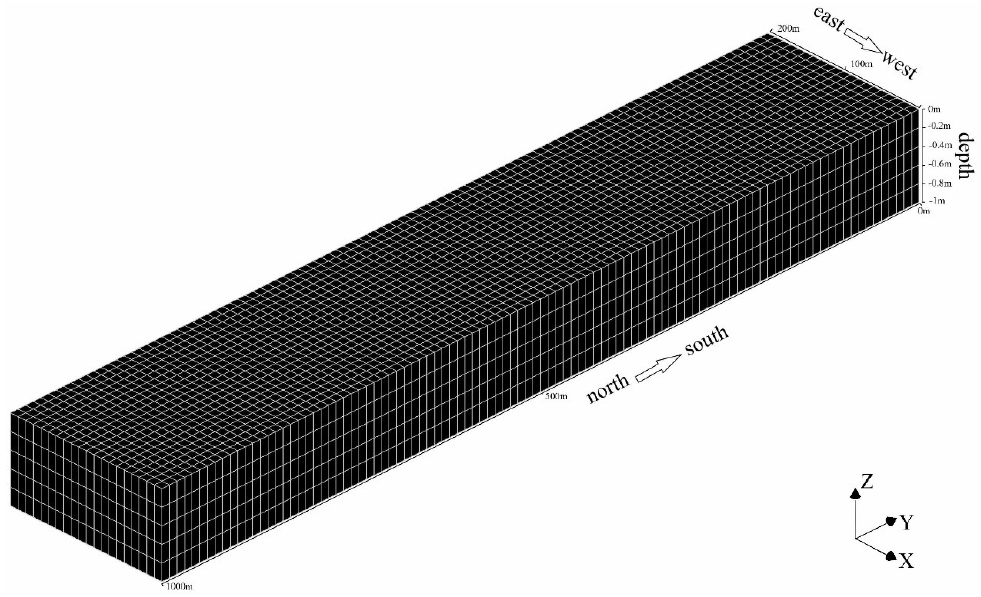
Figure 2. 3D mesh model of the test area.